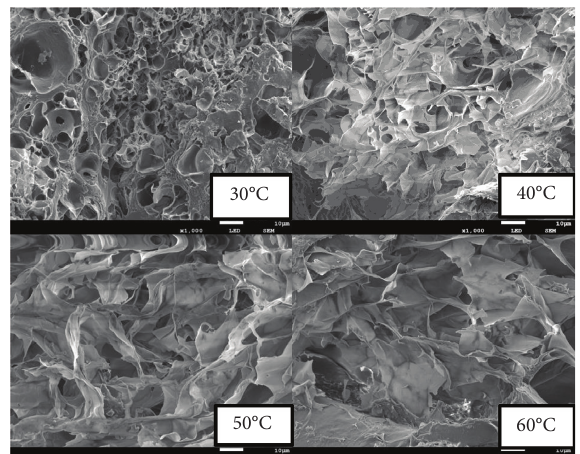
Figure 5: SEM images of rehydrated sea cucumber under different drying temperatures (1000 ×